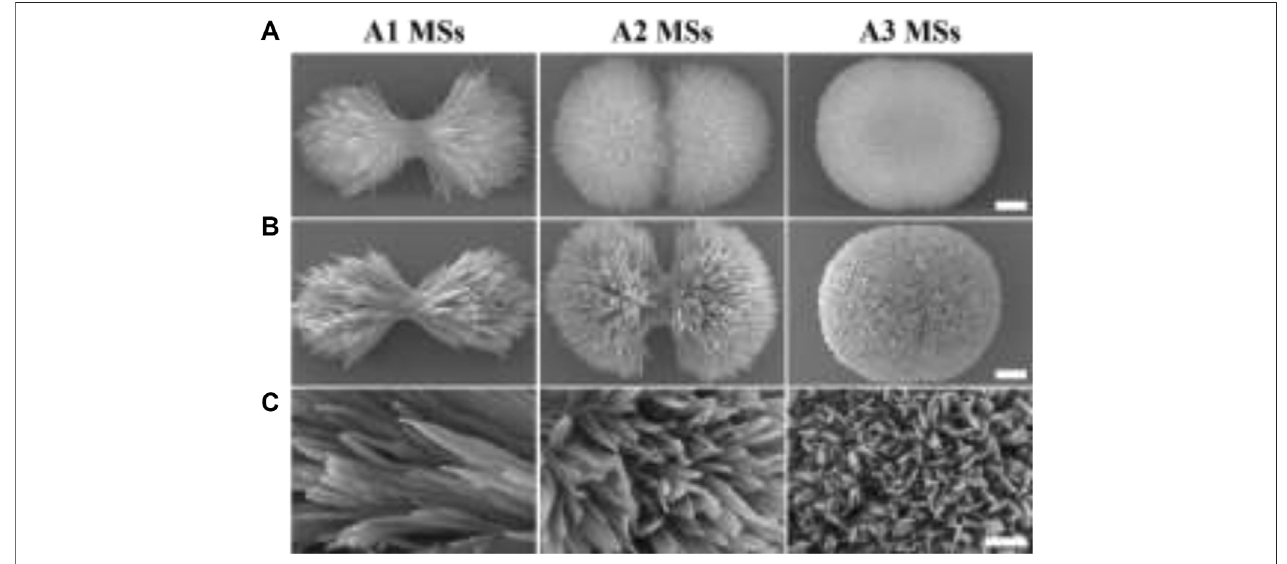
FIGURE 1 | The morphology of HA MSs and HA/AMPs MSs. (A) Morphology of diverse HA MSs, bar (cid:2) 0.5 µm. (B) Morphology of different HA/AMPs MSs, bar (cid:2) 0.5 µm. (C) Magni fi ed images of the surface topography of HA/AMPs MSs, bar (cid:2) 0.2